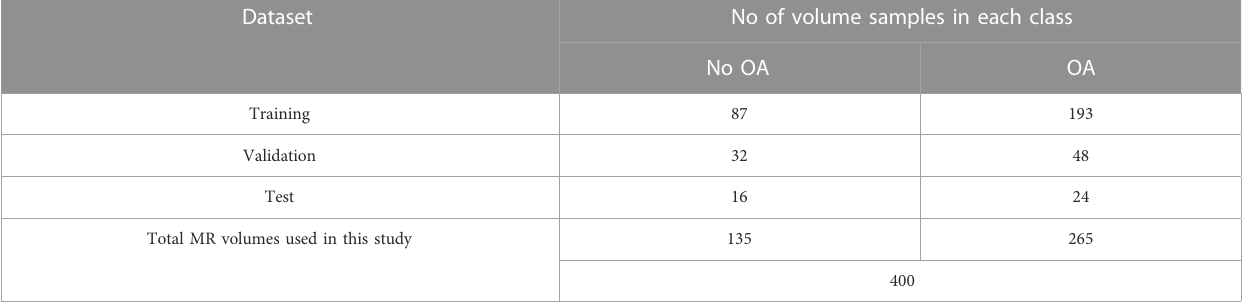
TABLE 1 Distribution of